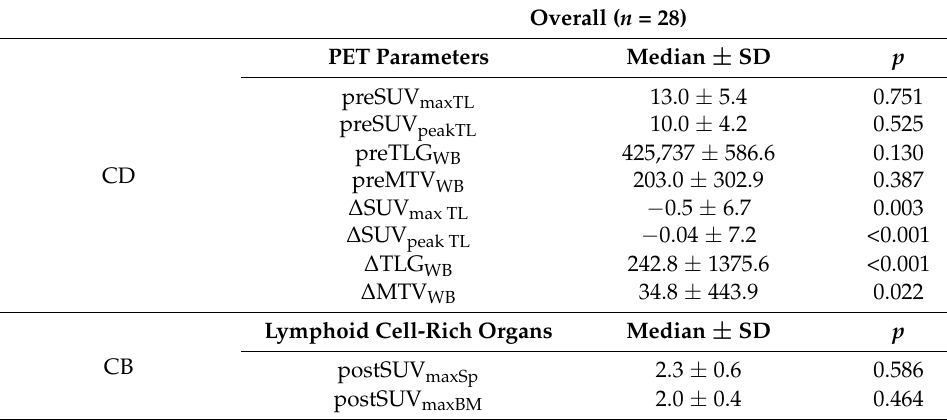
Table 3. PET-derived parameters and interval change.